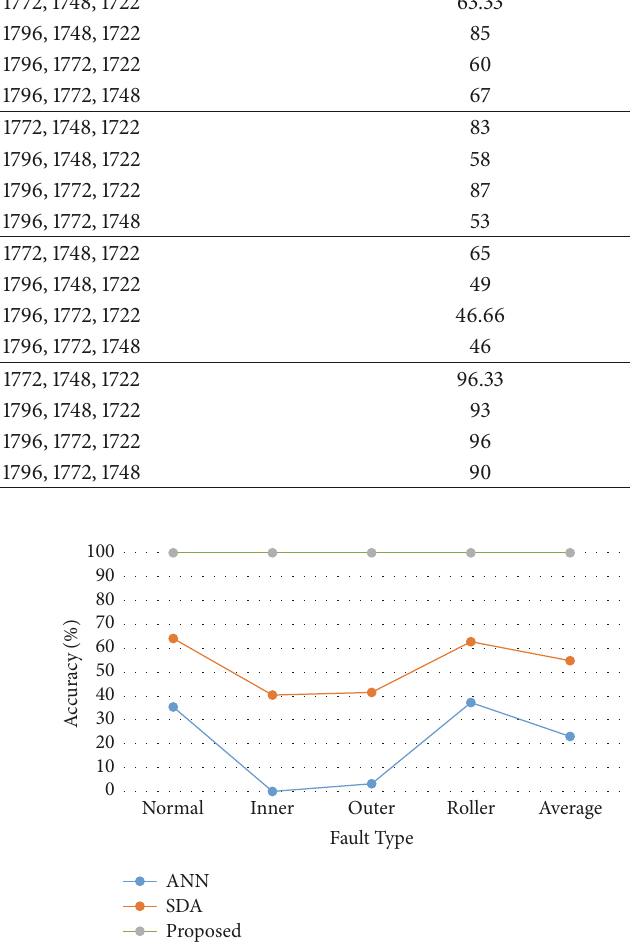
Figure 9: The accuracy of the proposed model, SDA, and ANN when subsamples from every fault condition and RMP were used for training the